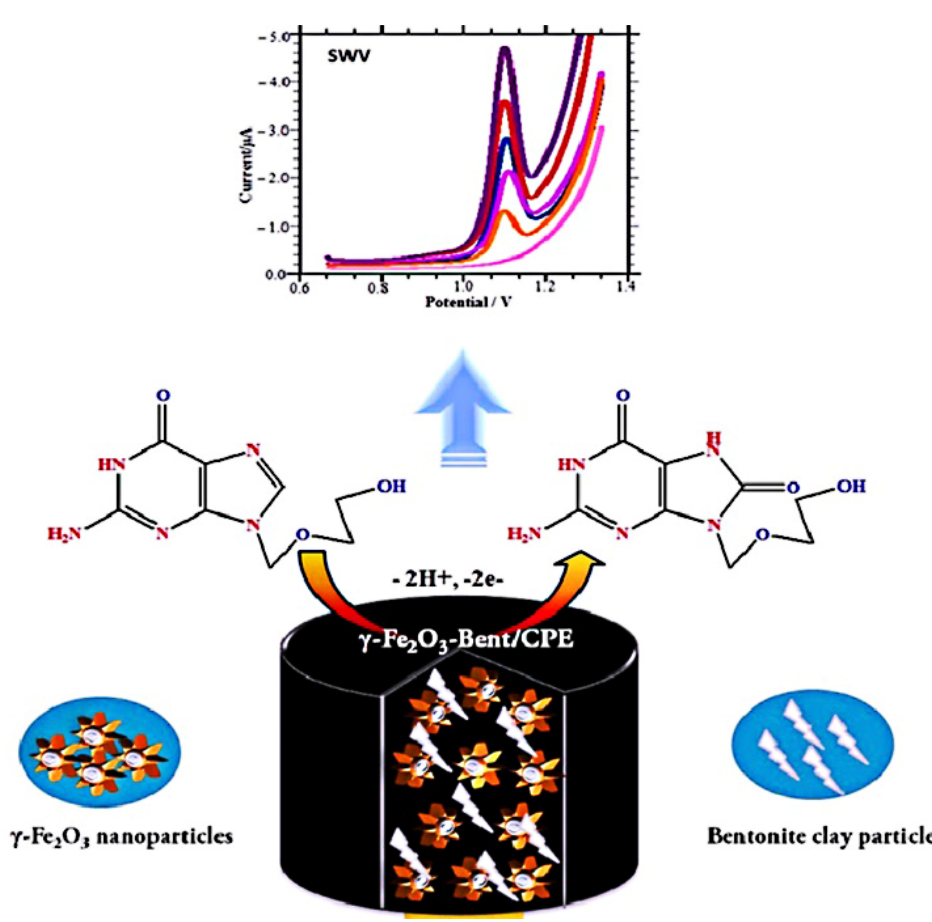
Figure 5. Schematic representation for the γ -Fe 2 O 3 -Bent/CPE detecting ACV (reproduced with permission [6], copyright 2020, Elsevier B.V.). Table 9. Various electrochemical sensors for the detection of ACV (“N.A”: No data applicable or available). Electrochemical